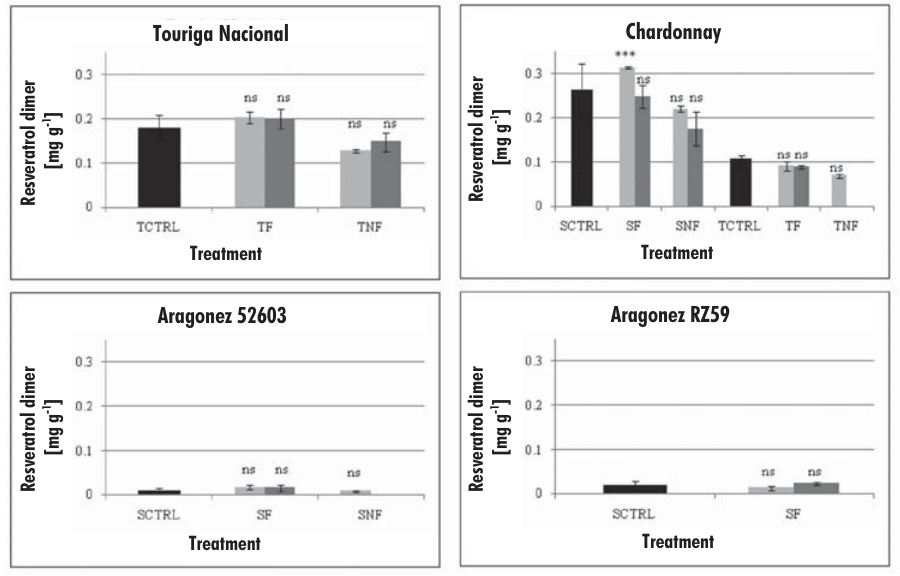
Fig. 4. Resveratrol dimer content in healthy and infected plants, from cv. Touriga Nacional, cv. Chardonnay, cv. Aragonez (52603) and cv. Aragonez (RZ59). Different tissue types are represented with infected plants: colonised trunk tissue (TF), uncolonised trunk tissue (TNF), colonised shoot tissue (SF) and uncolonised shoot tissue (SNF). Error bars represent standard deviation (n=4). Level of statistical signi fi cance is also indicated as *, P <0.05; **( P <0.01); ***, P <0.001; ns, non-signi fi cant. Control ( ¢ ), PH9 ( ¢ ), PH13 ( ¢ ). For control treatments, TCTRL refers to trunk control and SCTRL refers to shoot